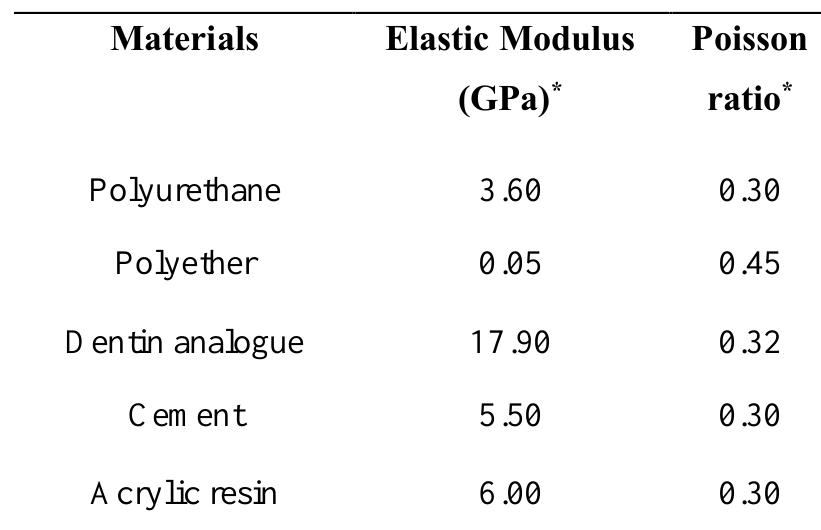
Table 1. Material properties used for the finite element analysis.